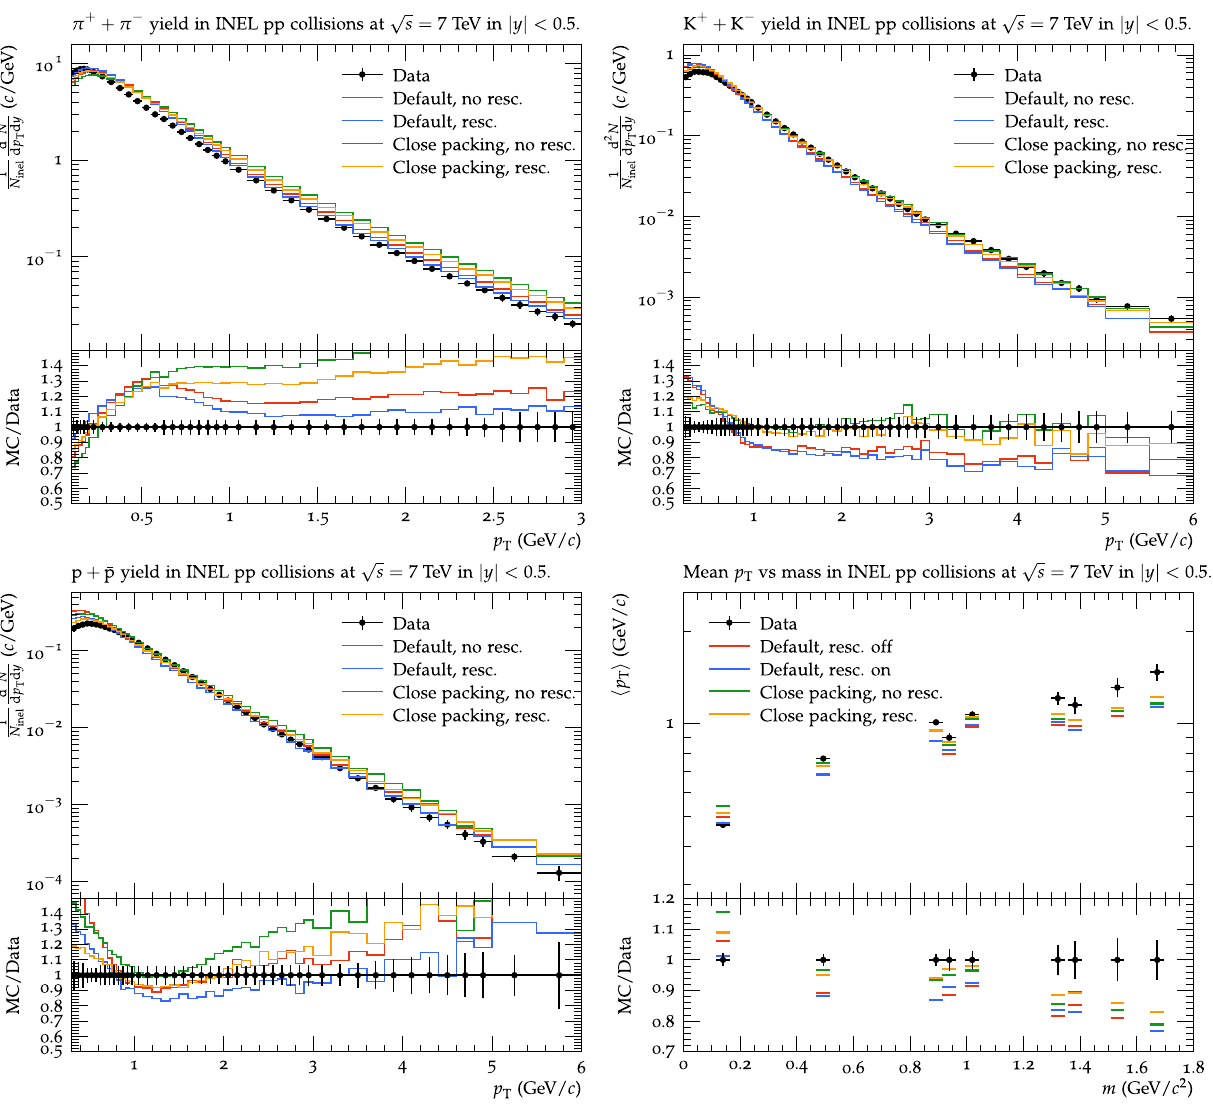
Fig. 22 p ⊥ spectra for π ± , K ± and p / p and average p ⊥ for various particles, for the Gaussian model with and without close-packing corrections. When using the close-packing corrections, pT0Ref has been tuned to 2.18 without rescattering and 2.25 with rescattering on, in order to restore the correct n